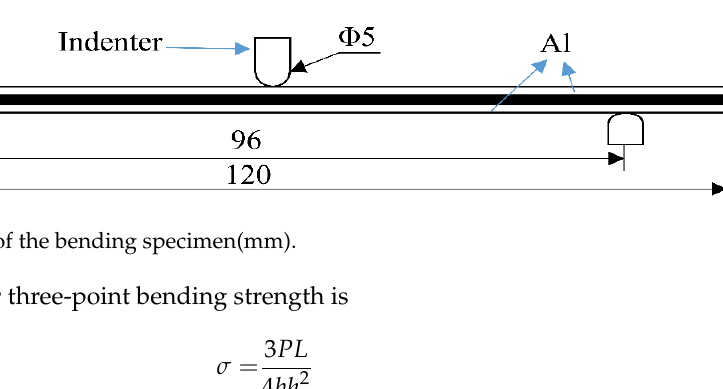
Figure 3. Dimensions of the sheared sample(mm).